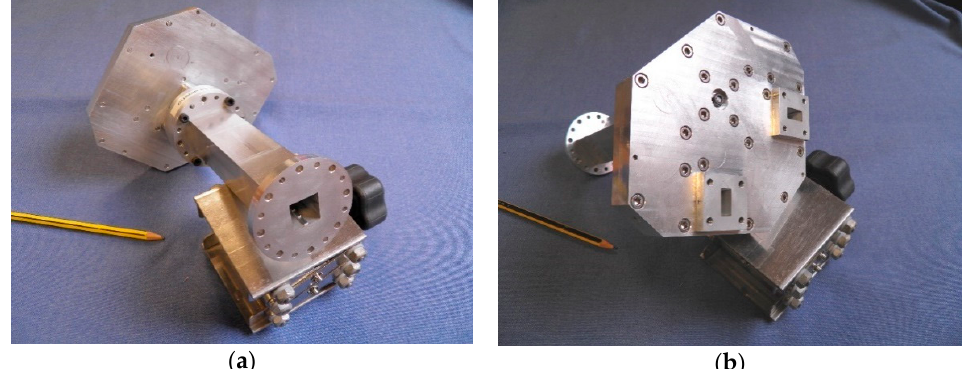
Figure A2 . Assembly polarizer-OMT: ( a ) polarizer square waveguide input view; ( b ) OMT rectangular waveguide outputs view.